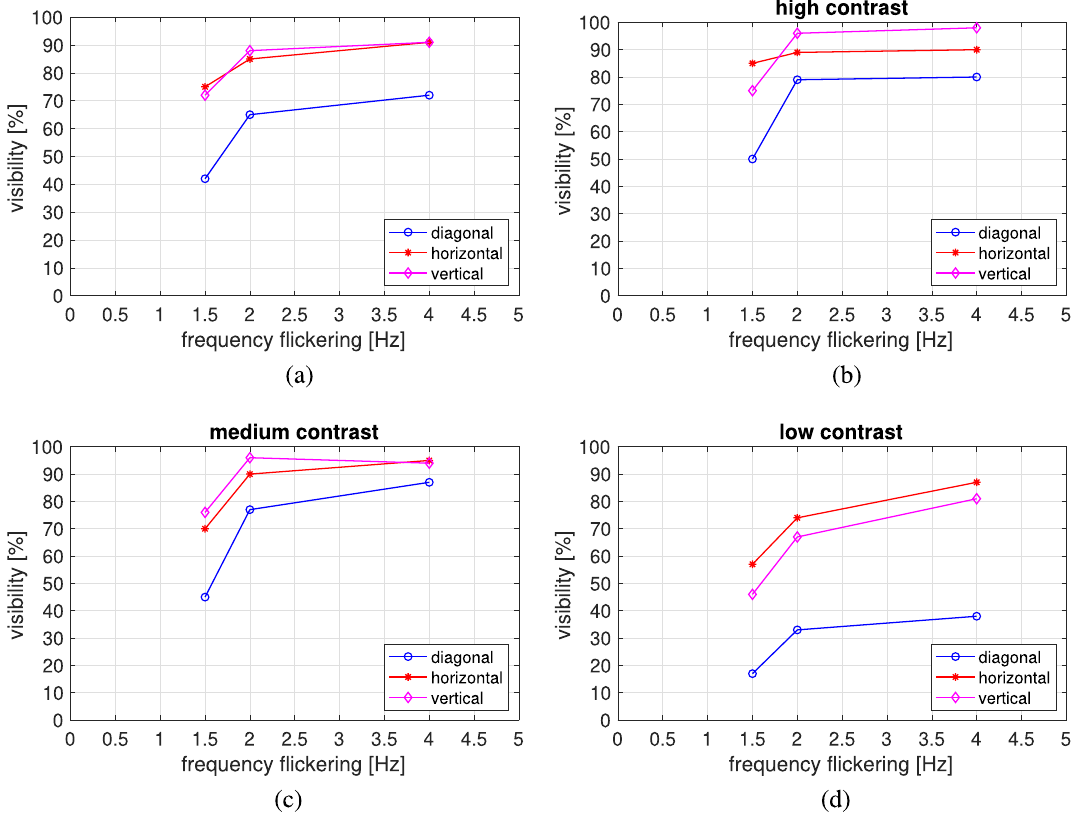
Figure 5. Disk visibility is represented as the percentage of users noticing stimuli given for ( a ) a general approach (mean contrast), ( b ) a high contrast, ( c ) a medium contrast, and ( d ) a low contrast of disc color and background, given for three different frequencies of flickering: 1.5 Hz, 2 Hz, and 4 Hz and for three different angular distances: horizontal (46 deg), vertical (70 deg), and diagonal (80